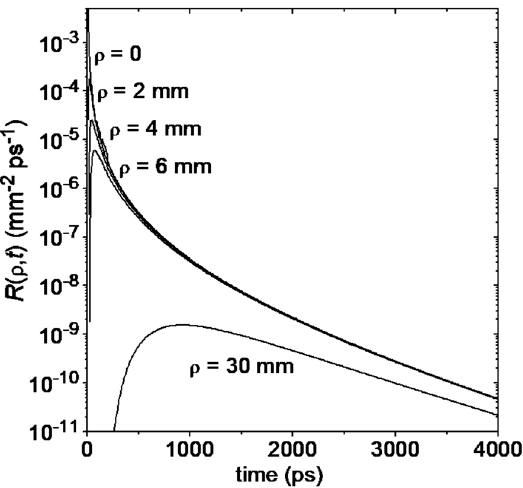
Figure 2. The null source-detector distance ( ρ ) increases the number of collected photons at all times with respect to a larger ρ (modified from [38]).